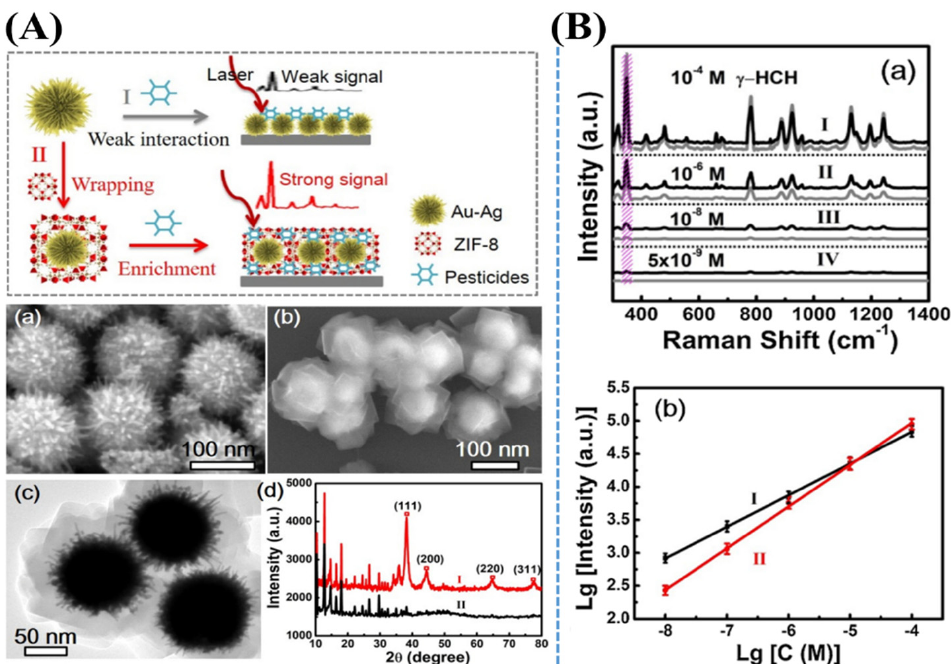
Figure 5. Schematic illustration of SERS detection of hexachlorocyclohexane pesticides based on urchin-like Au-AgNPs. ( A – a ) Scanning electron microscope (SEM) image shows the structures of urchin-like Au-AgNPs. ( A – b ) SEM image and ( A – c ) transmission electron microscope (TEM) image of the nanomaterial products obtained after adding the ZIF-8-wrapped urchin-like Au-AgNPs into the precursor solution and heating them at 40 °C for 3 h. ( A – d ) X-ray diffraction patterns including (I) nanomaterial products and (II) pure ZIF-8 achieved by heating the precursor solution at 40 °C for 3 h, respectively. ( B – a ) SERS spectra of γ -HCH on the ZIF-8 wrapped urchin-like Au-AgNPs (black), and bare urchin-like Au-AgNPs (grey) after soaking in γ -HCH solutions with different concentrations such as (I) 1 × 10 − 4 M, (II) 1 × 10 − 6 M, (III) 1 × 10 − 8 M, and (IV) 5 × 10 − 9 M, respectively, for both samples. The shadowed regions indicated that the characteristic peak of γ -HCH at 345 cm − 1 . ( B – b ) Linear curves of logarithmic plots of γ -HCH concentrations correlated to the Raman peak intensities at ca. 345 cm − 1 for the ZIF-8 wrapped (I), and (II) bare urchin-like Au-AgNPs. Adapted from [40].